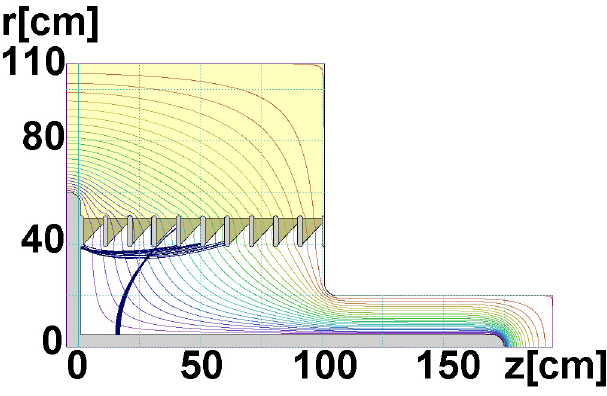
FIG. 5. (Color) Same as Fig. 4 but the insulator is replaced by a